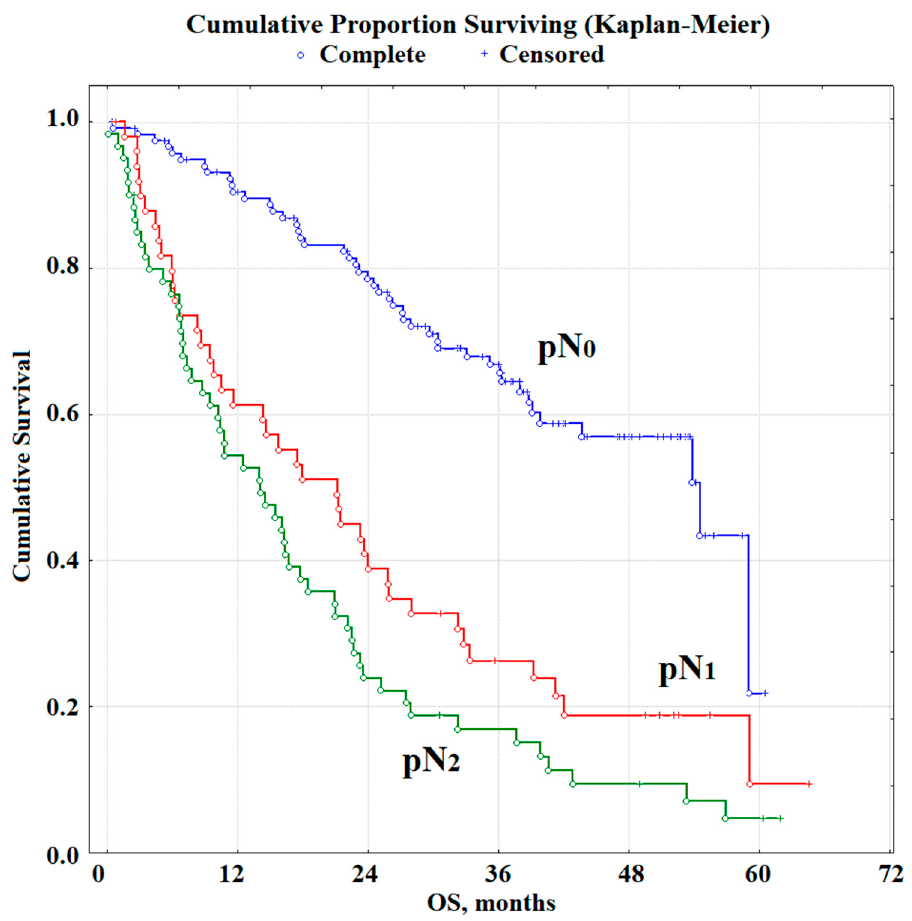
Figure 1. Kaplan–Meier survival curves illustrating the impact of pN stage on OS ( p < 0.00001). At the next stage of the study, subgroups were identified taking into account the characteristics of the tumor. Thus, with an increase in tumor size, OS naturally decrease, but the differences are statistically insignificant (Table 1). For pN 2 , the differences between the pT3 and pT4 stages are the smallest. When compared for one tumor size, for small tumors (T2) the relative risk increases statistically significantly between pN 0 and pN 1 , while further changes are insignificant: HR = 7.22, 95% CI 2.63–19.24 (pN 0 vs. pN 1 ) and HR = 6.64, 95% CI 2.68–16.02 (pN 0 vs. pN 2 ). For T3, comparing pN 0 vs. pN 1 , there is a 4-fold increase in risk (HR = 4.33, 95% CI 1.29–14.25), while comparing pN 0 vs. pN 2 , there is a 12-fold increase in relative risk (HR = 11.82, 95% CI 2.23–10.48, p < 0.00001). For stage T4 with lesion of pN 1 , the minimum OS were